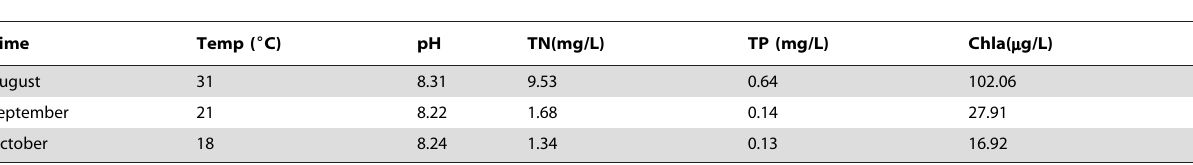
Table 1. Environmental variables at the three sampling times.